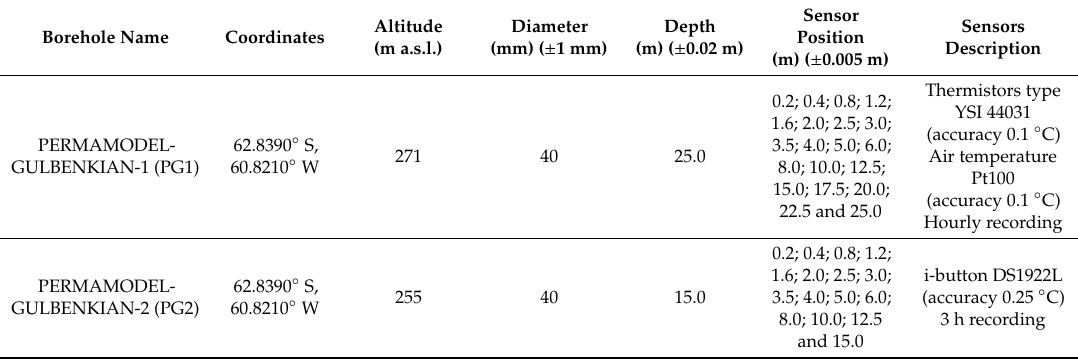
Table 1. Characteristics of the boreholes PG1 and PG2 and its thermometric